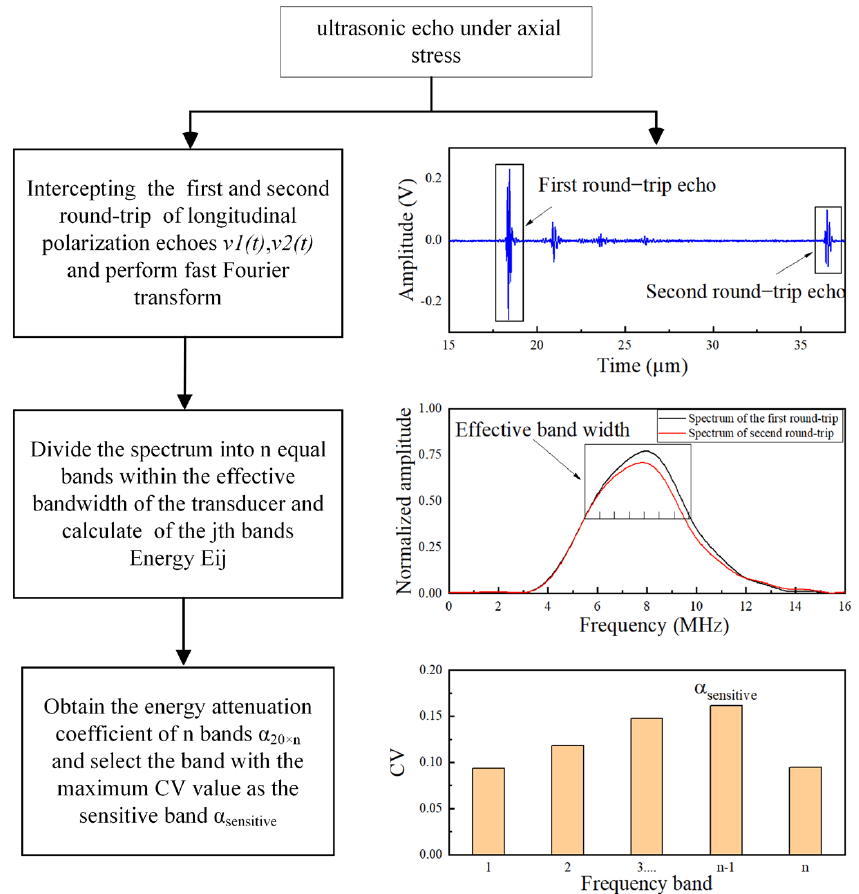
Figure 3. Flow chart of the calculation of energy attenuation coefficient. During the propagation process, the ultrasonic waves will occur in a series of re- flections and mode conversions at the bolt boundary. When the ultrasonic longitudinal transducer is located at the surface of the bolt head, part of the signal in the main flap region is unaffected by the boundary and reaches the end of the bolt directly. Therefore, the normally incident longitudinal-to-longitudinal ultrasound (travels one and two round-trips in the bolt of longitudinal wave polarization direction) is used to characterize scattering attenuation under uniaxial stress, as shown in Figure 3. A rectangular window is em- ployed to intercept ultrasonic echoes traveling the first round-trip v 1 ( t ) and second v 2 ( t